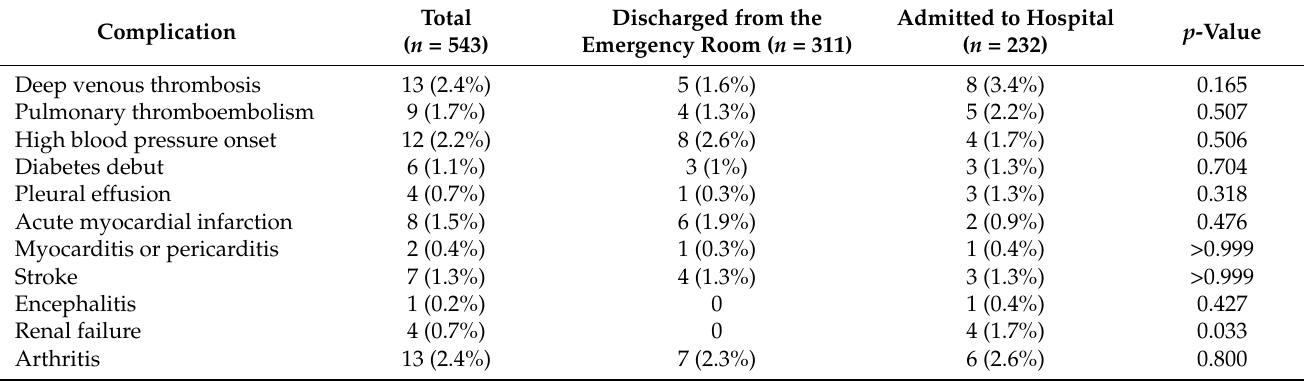
Table 2. Complications reported within the first year after recovering from acute COVID-19 in patients attending Tomelloso General Hospital during the first wave of the